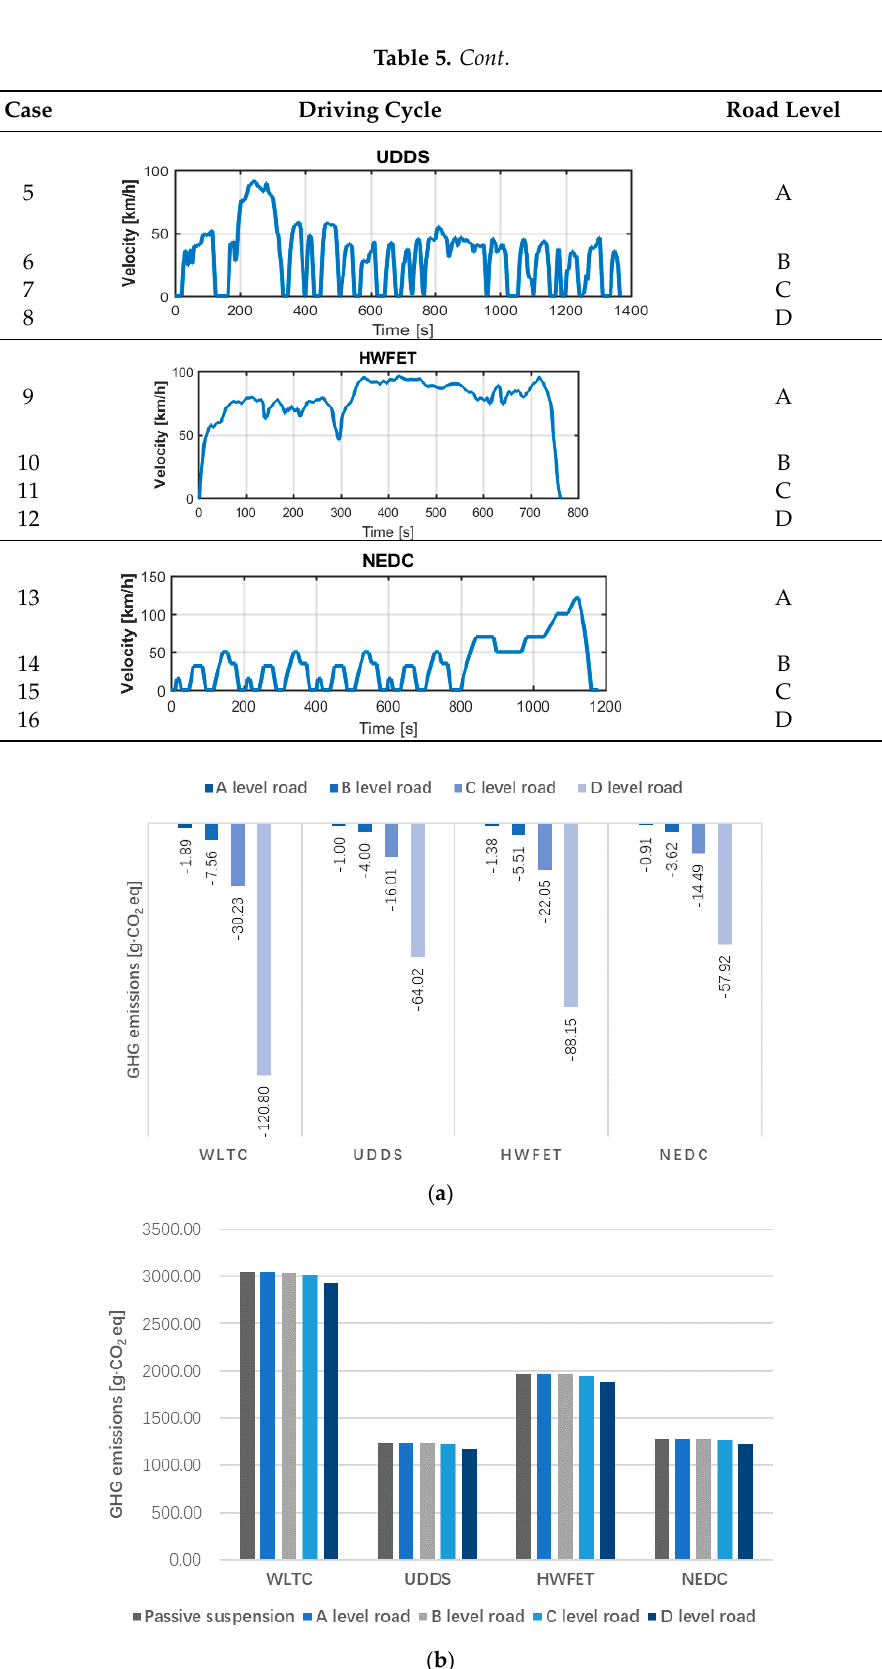
Figure 12. Comparative results for different cases. ( a ) Suspension GHG emission reduction; ( b ) WTW GHG emissions of a light-duty BEV.